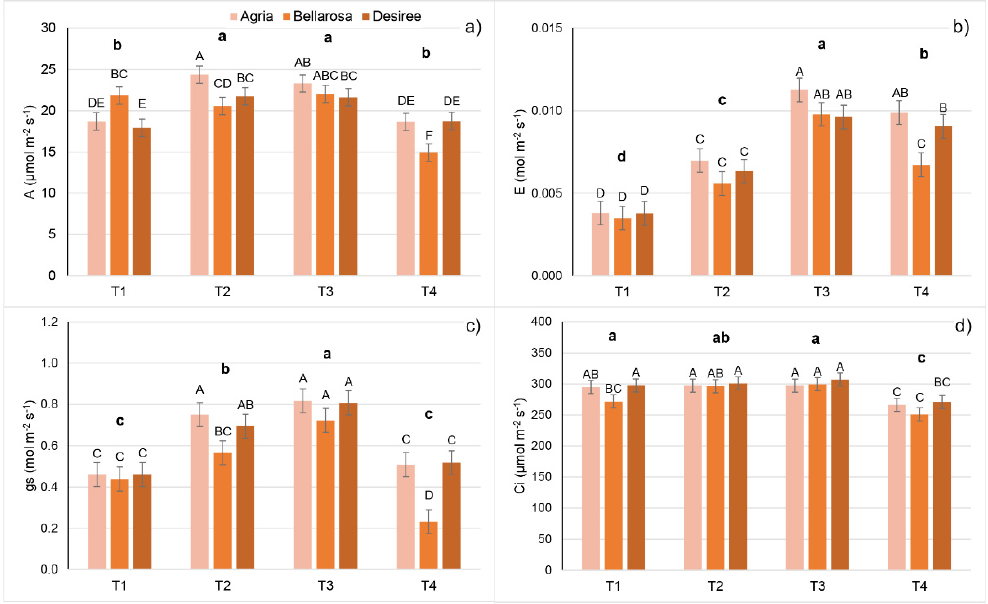
Figure 6. Mean values and double standard error of the mean for the gas exchange traits: ( a ) Photosynthesis rate (A, µ mol CO 2 m − 2 s − 1 ), ( b ) transpiration rate (E, mol H 2 O m − 2 s − 1 ), ( c ) stomatal conductance to water vapor (gs, mol H 2 O m − 2 s − 1 ), and ( d ) the intercellular CO 2 concentration (Ci, µmol CO 2 m − 2 s − 1 ) of potato cultivars (Agria, Bellarosa, and Desiree) after ten days of growth in four different temperature treatments: 20/15 °C (T1), 25/20 °C (T2), 30/25 °C (T3), and 35/30 °C (T4). Different uppercase letters indicate significant differences for cultivar × treatment interaction; different lowercase letters in bold indicate significant differences between temperature treatments (Tukey’s HSD test p < 0.05).